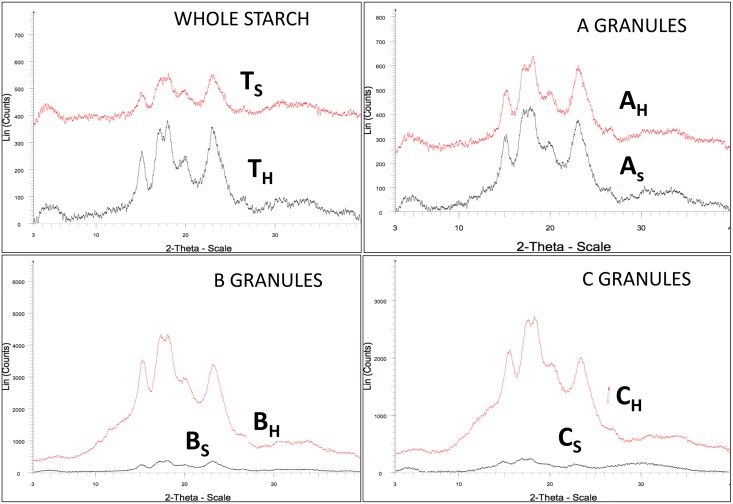
XRD pattern of starch granules.